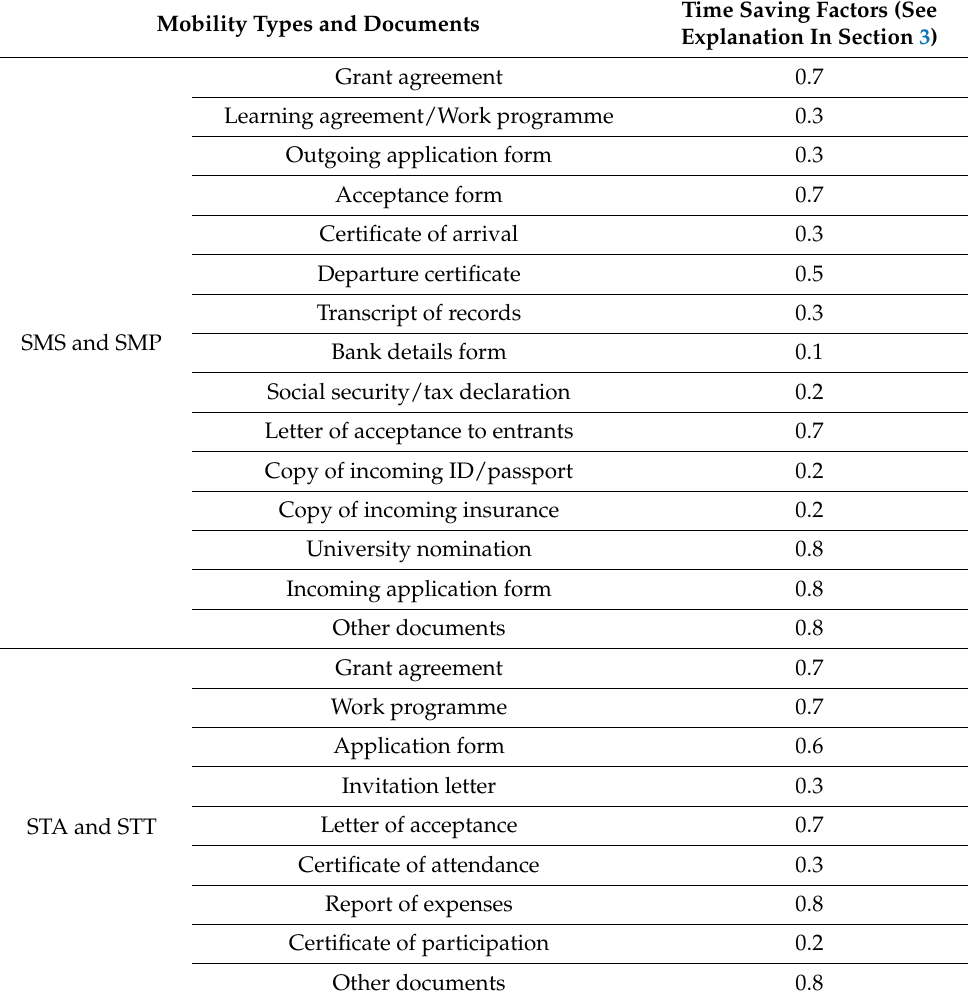
Table 4. Summary of the time saving factors (TSF) indicated by the consulted IRO staff for the different types of documents 1